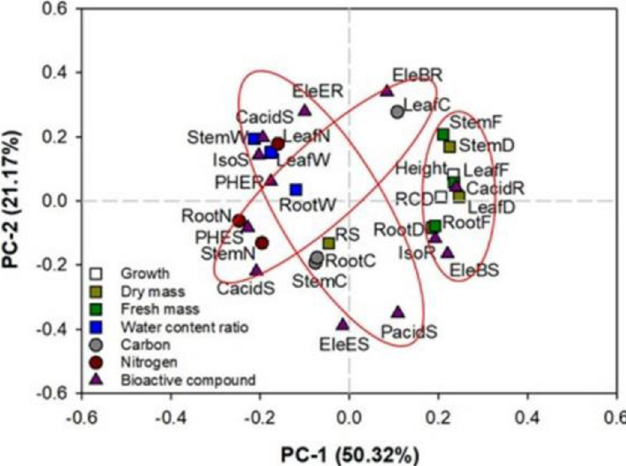
Fig 9. Principal component (PC) analysis of parameters about growth, dry mass, fresh mass, WCR, C concentration, N concentration, and bioactive compound contents in shoots and roots of Eleutherococcus senticosus seedlings subjected to combined spectra and chitosan nanoparticle addition treatments. Height, shoot height; RCD, root-collar diameter; LeafD, leaf dry mass weight; StemD, stem dry mass weight; RootD, root dry mass weight; RS, root to shoot dry mass ratio; LeafF, leaf fresh mass weight; StemF, stem fresh mass weight; RootF, root fresh mass weight; LeafW, leaf WCR; StemW, stem WCR; RootW, root WCR; LeafC, leaf C concentration; StemC, stem C concentration; RootC, root C concentration; LeafN, leaf N concentration; StemN, stem N concentration; RootN, root N concentration; PHES, stem phenylalanine content; PacidS, stem protocatechuic acid content; CacidS, stem chlorogenic acid; EleBS, stem eleutheroside-B content; EleES, stem eleutheroside-E content; IsoS, stem isofraxidin content; PHER, root phenylalanine content; PacidR, root protocatechuic acid content; CacidR, root chlorogenic acid; EleBR, root eleutheroside-B content; EleER, root eleutheroside-E content; IsoR, root isofraxidin content. the HPS spectrum. Our white-light LED spectrum had a similar proportion of red, green, and blue lights as the HPS spectrum. The promotion of R/S given exposure to the white-light LED